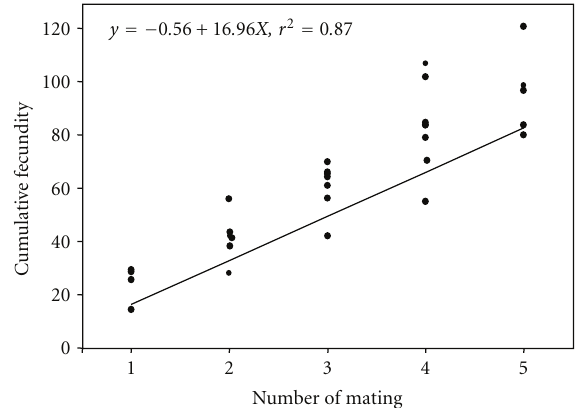
Figure 2: Relation between number of mating and cumulative fecundity (cumulated number of eggs/female after successive mat- ing). A linear model was adjusted to the variables. Points indicate the cumulative number of eggs of each individual observed and line the values estimated from the adjusted model.